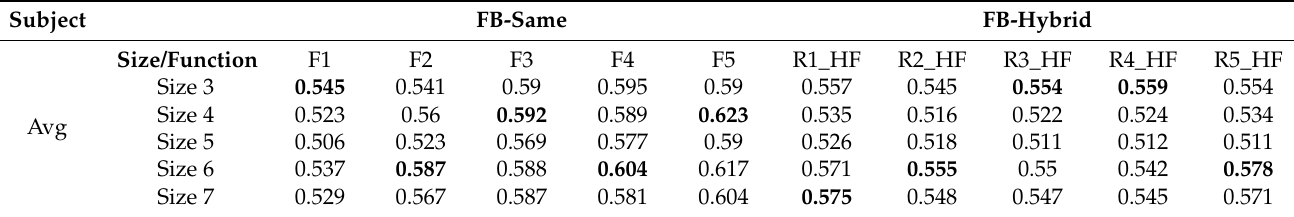
Table 16. Reduction data based on pooling model on filter banks with different window sizes for all filter banks with the same function in layers or randomly FB 5 and all of FBs and RF for 10